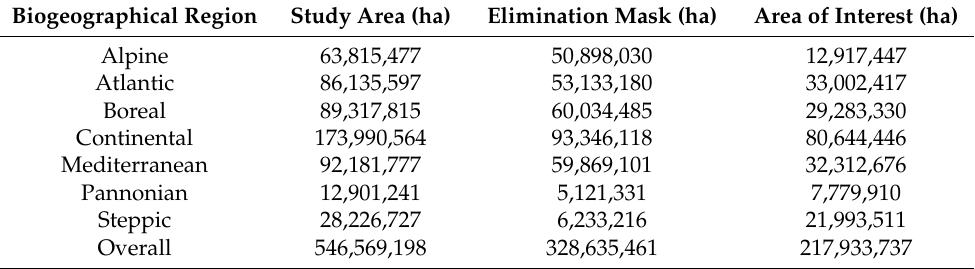
Table 1. Calculation of the area of